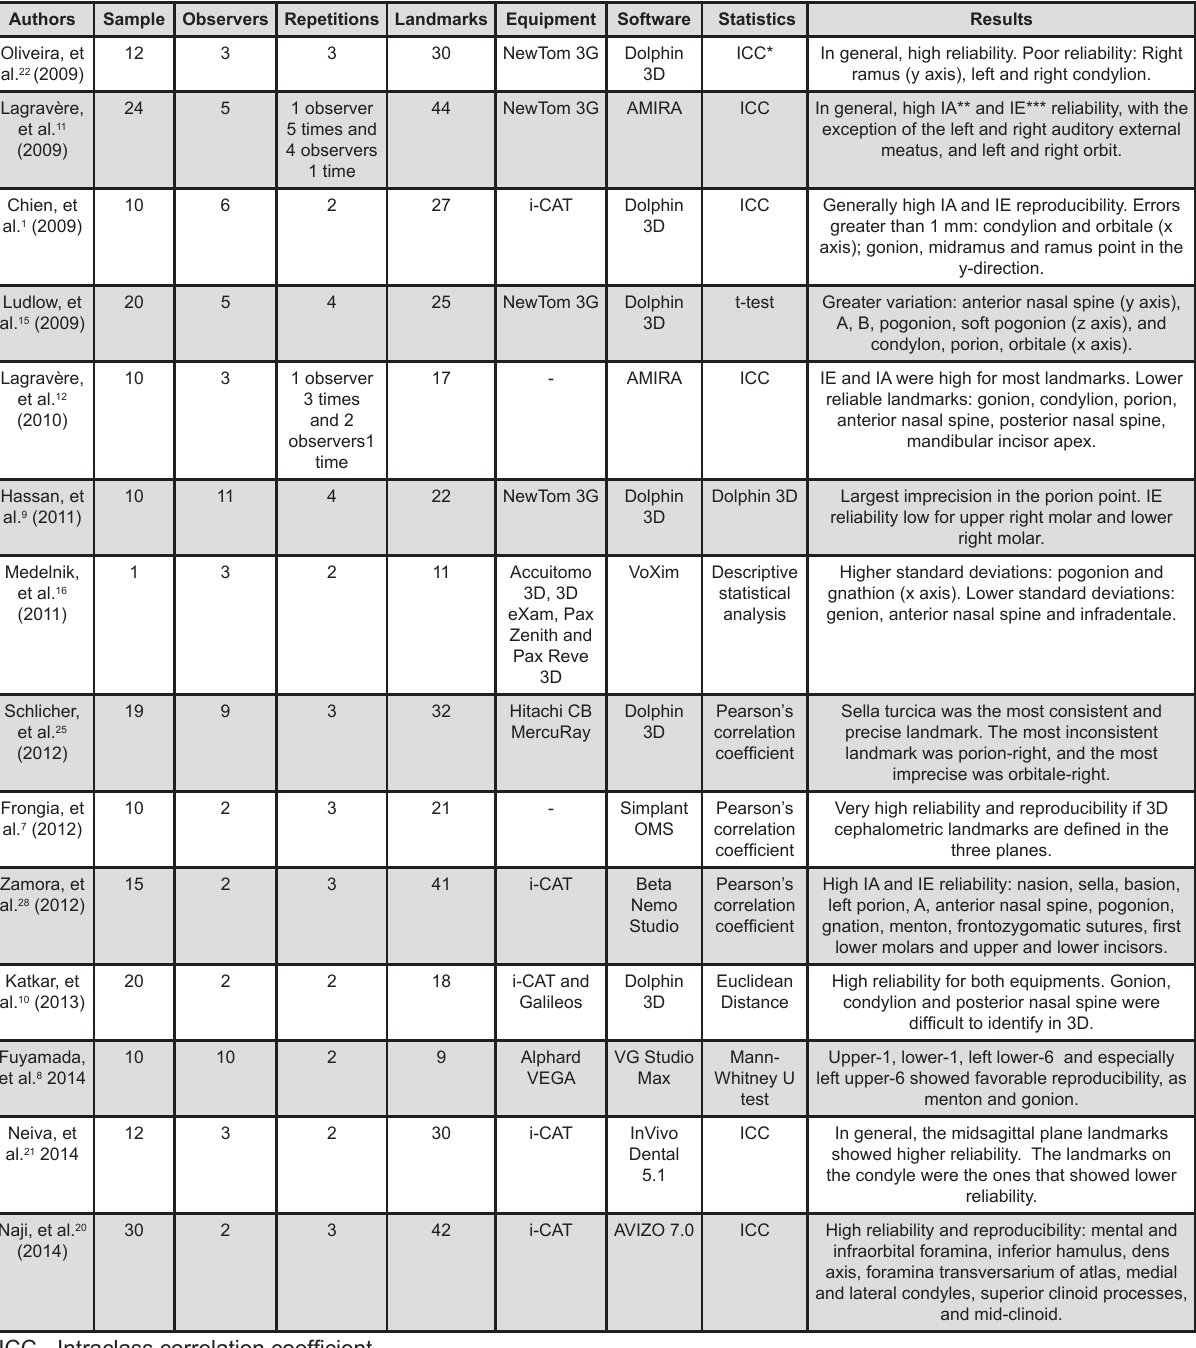
Figure 6- Description of the included